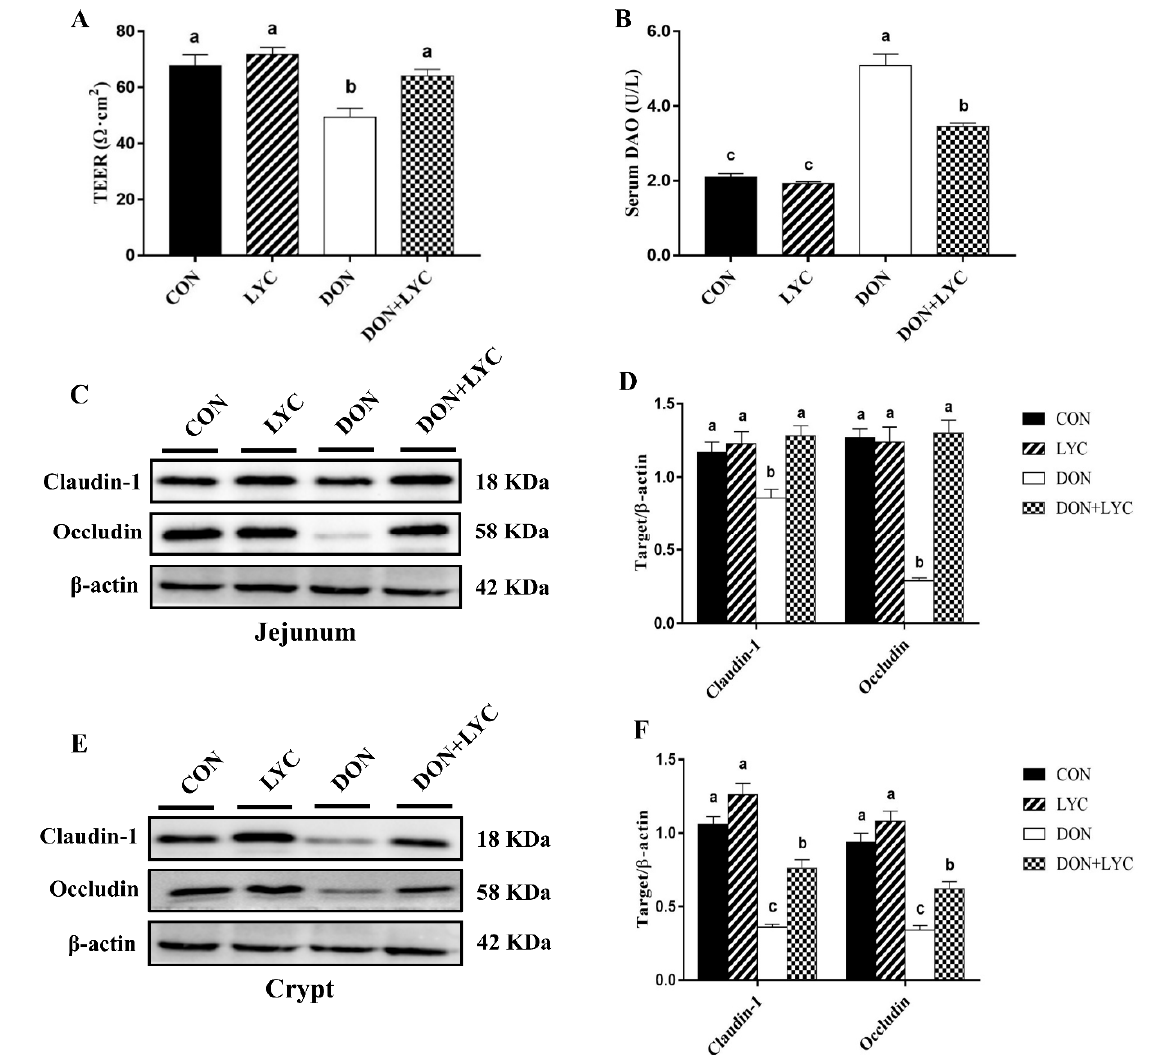
Figure 3. LYC treatment prevents the intestinal barrier disruption of mice induced by DON. ( A ) TEER in the jejunum. Results are presented as mean ± SEM ( n = 3). ( B ) DAO activity in the serum. The results are expressed as mean ± SEM ( n = 6). ( C , D ) Protein expression of claudin-1 and occludin in the jejunum and ( E , F ) protein expression of claudin-1 and occludin in the crypt. Results are presented as mean ± SEM ( n = 3). Columns with different superscripts letters indicating significant difference ( p < 0.05). TEER, Trans-epithelial electrical resistance; DAO, diamine oxidase.